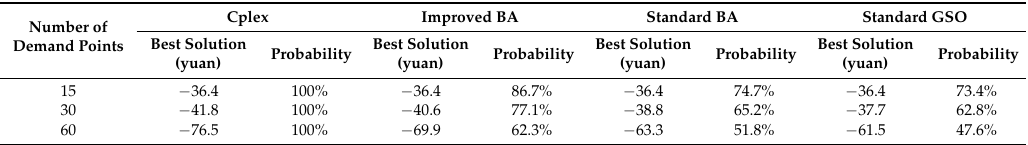
Table 6. Comparison of different algorithms.